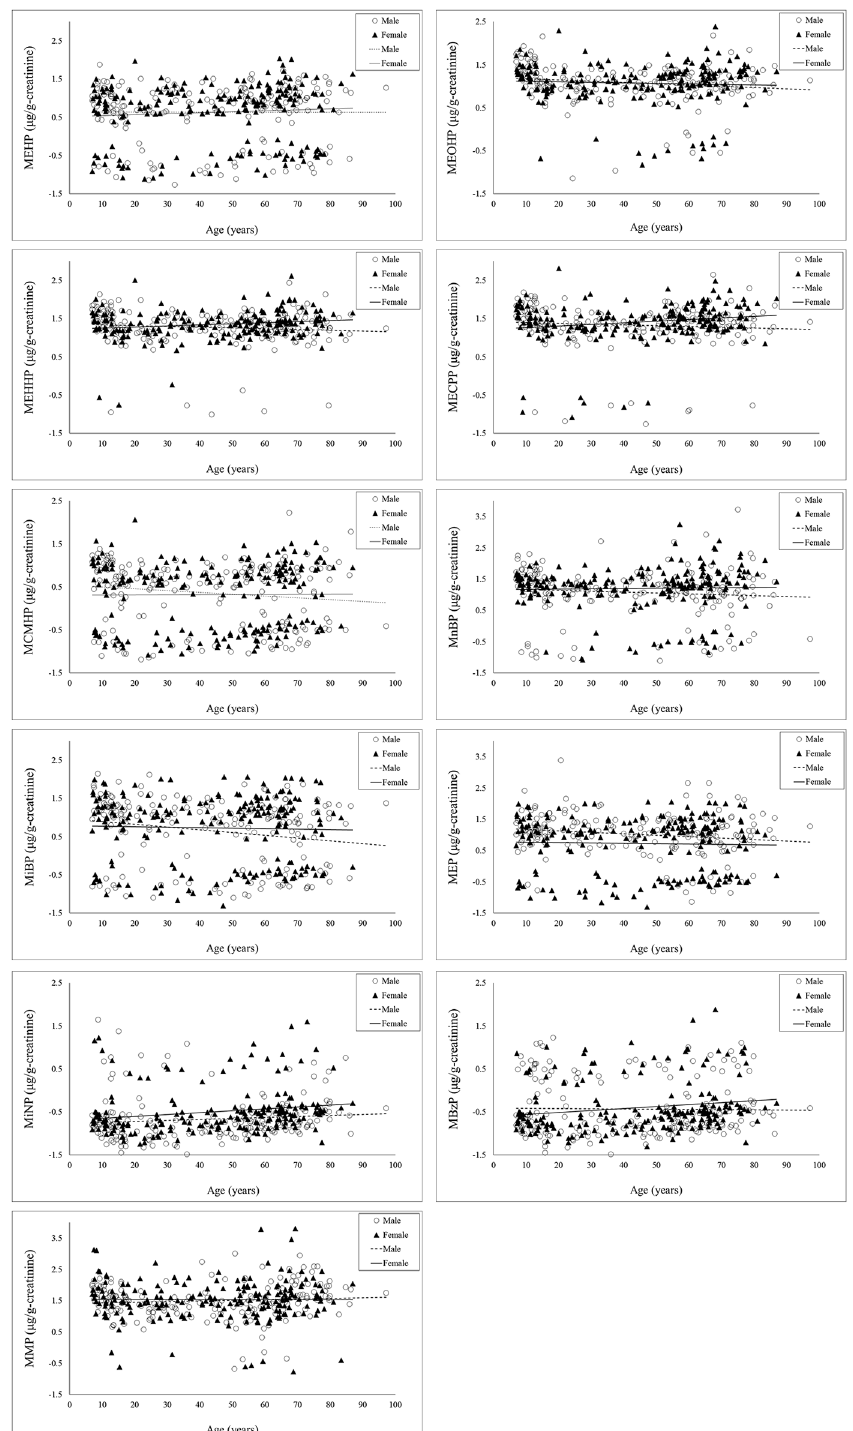
Fig 2. Distribution of 11 phthalate metabolites in a sample of the general Taiwanese population (N = 387) (cid:1) 7 years of age.